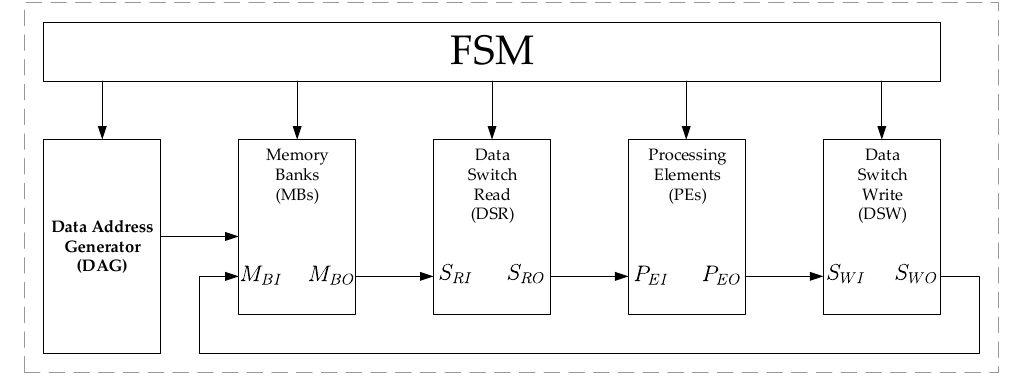
Figure 4. FFT architecture with our proposed addressing scheme. FSM: Finite State